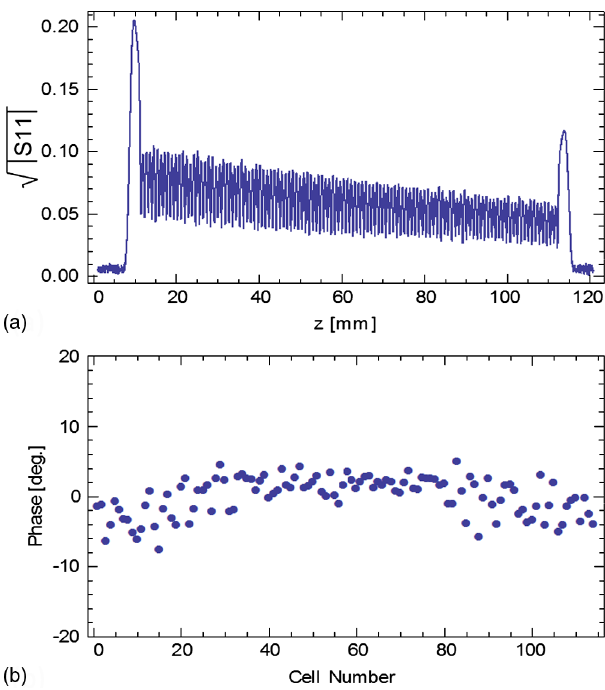
FIG. 9. Results of bead pull measurements: (a) rf electric field amplitude along the central axis of the deflector; (b) difference between beam synchronous phase and rf phase along the central axis of the deflector.